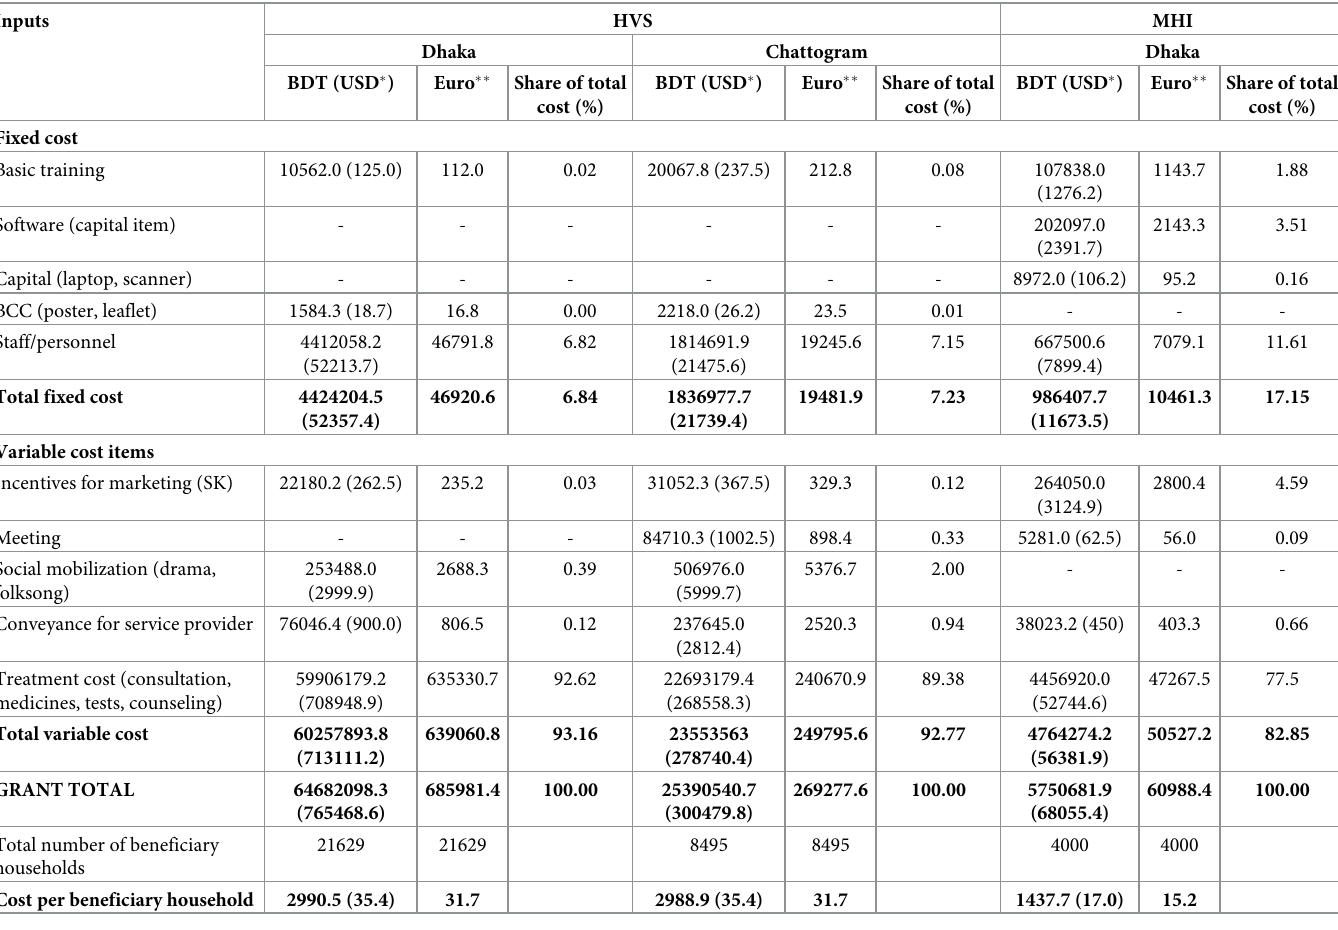
Table 9. Distribution of provider cost and cost per beneficiary household of HVS and MHI scheme per